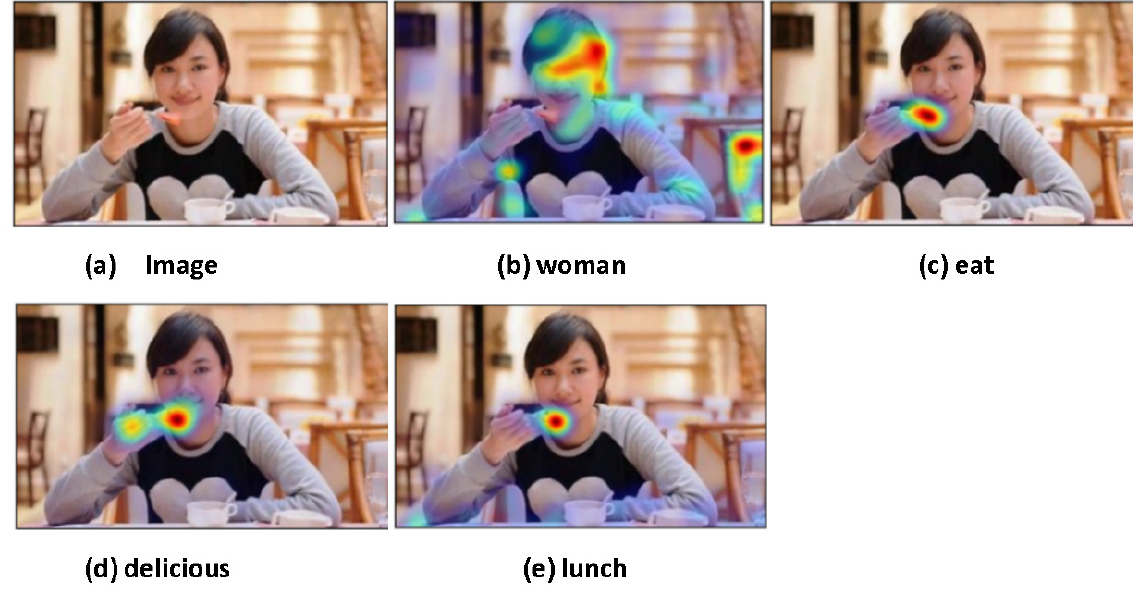
Figure 6. ( a ) is the original picture. The following sentence is input: woman is eating delicious lunch. Our model can be used to detect this sentence word by word, and the heat maps are shown in the figures above. Obviously, our model can find the region of interest corresponding to the text. Meanwhile, our model can not only detect the objects, but also detect their position, behavior, color, and other advanced attributes.